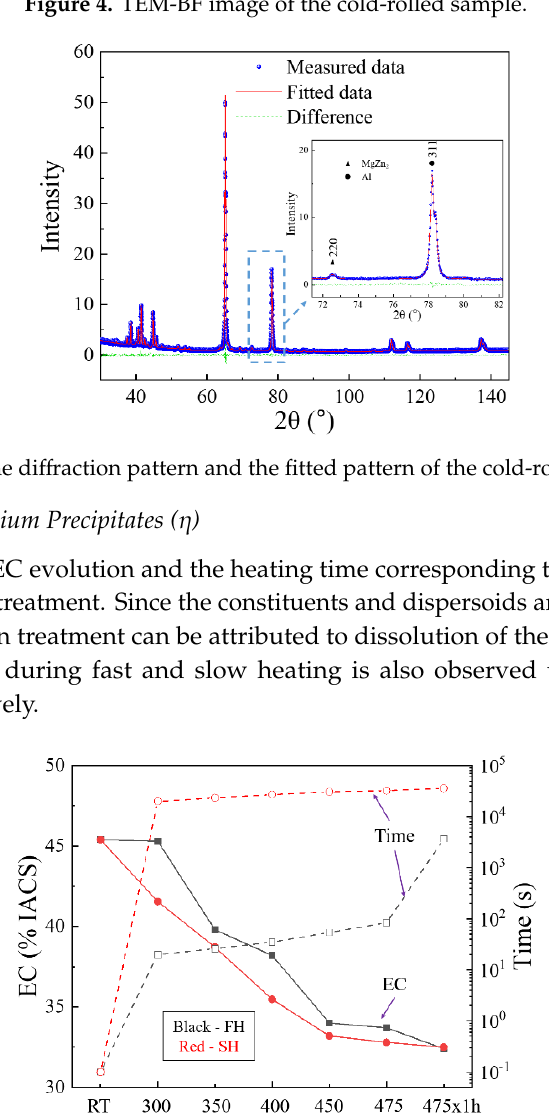
Figure 4. TEM-BF image of the cold-rolled sample.